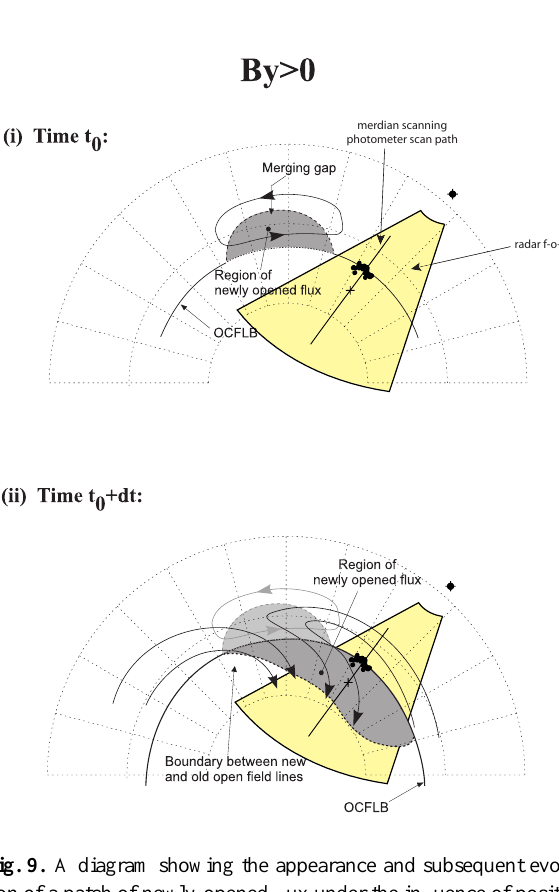
Fig. 9 Fig. 9. A diagram showing the appearance and subsequent evolu- tion of a patch of newly-opened flux under the influence of positive IMF B y conditions. This schematic has been adapted from Fig. 9c previously shown in Cowley and Lockwood (1992). The solid semi- circle represents the open/closed field line boundary, which has been positioned over our estimated boundary location (small dots ∼ 10 MLT and 73 ◦ ). The f-o-v of the radar at 07:00UT is shown by the yellow shaded area with the location and the meridian scan of the MSP shown by the cross and line in the middle of the radar f-o-v. The grey shaded area represents the newly-open flux ap- pended to the dayside boundary. The curved arrows indicate the convection streamlines. The initial response of reconnection under positive IMF B y (a) evolves into (b) after a short time. The flow is initially localised within the region of the newly-opened flux ap- pended to the open/closed field line boundary (OCFLB). Thereafter, the tension force imposed by IMF B y pulls the flow westward pro- ducing an azimuthal flow at lower latitudes before turning poleward at higher latitudes into the polar cap. The OCFLB moves equator- ward and the region of newly-opened flux extends longitudinally (adapted from Cowley and Lockwood,